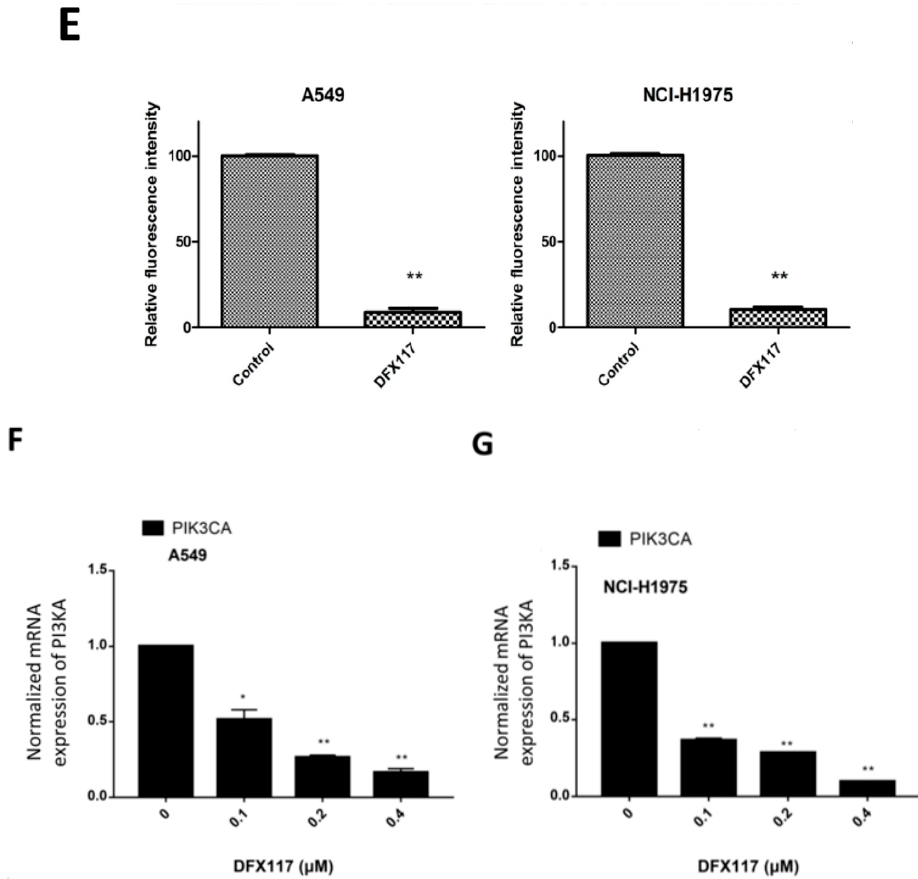
Figure 2. DFX117 suppresses the PI3K signaling pathway. ( A , B ) DFX117 suppressed the PI3K- signaling pathway in A549 and NCI-H1975 cells. Cells were collected for Western blot analysis after DFX117 treatment for 24 h at the indicated concentrations. The alterations in PI3K signaling related protein levels were quantified using Image J software. ( C , D) Immunofluorescence analysis was performed to determine the e ff ects of DFX117 on the expression level of p-Akt (Ser473) in A549 and NCI-H1975 cells. The cells were treated with DFX117 (0.2 µ M) for 8 h, and then p-Akt expression was observed under a fluorescence microscope (magnification: 400 × ). DAPI staining was used to visualize and characterize the nucleus (blue). ( E ) Quantification of the fold changes in the expression levels of p-Akt is compared to the vehicle-treated control (lower panel). ( F , G ) DFX117 decreased the mRNA levels of PIK3CA in A549 and NCI-H1975 cells. Cells were treated with DFX117 for 24 h and then collected for RT-PCR analysis. * p < 0.05 or ** p < 0.01 was considered statistically significant compared with the corresponding control values.